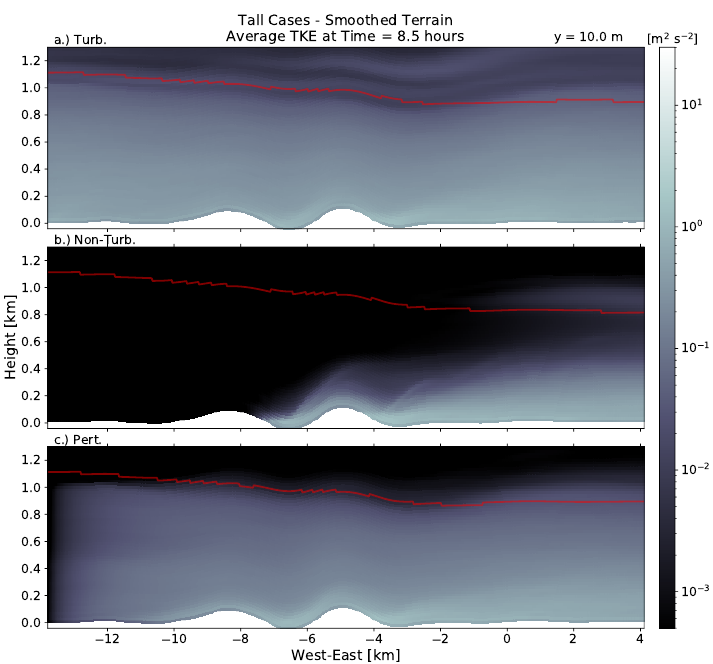
Figure 19. Same as in Figure 8 but for time-averaged TKE for simulations over smoothed terrain in the Tall cases for the ( a ) Turbulent, ( b ) non-turbulent, and ( c ) cell perturbation